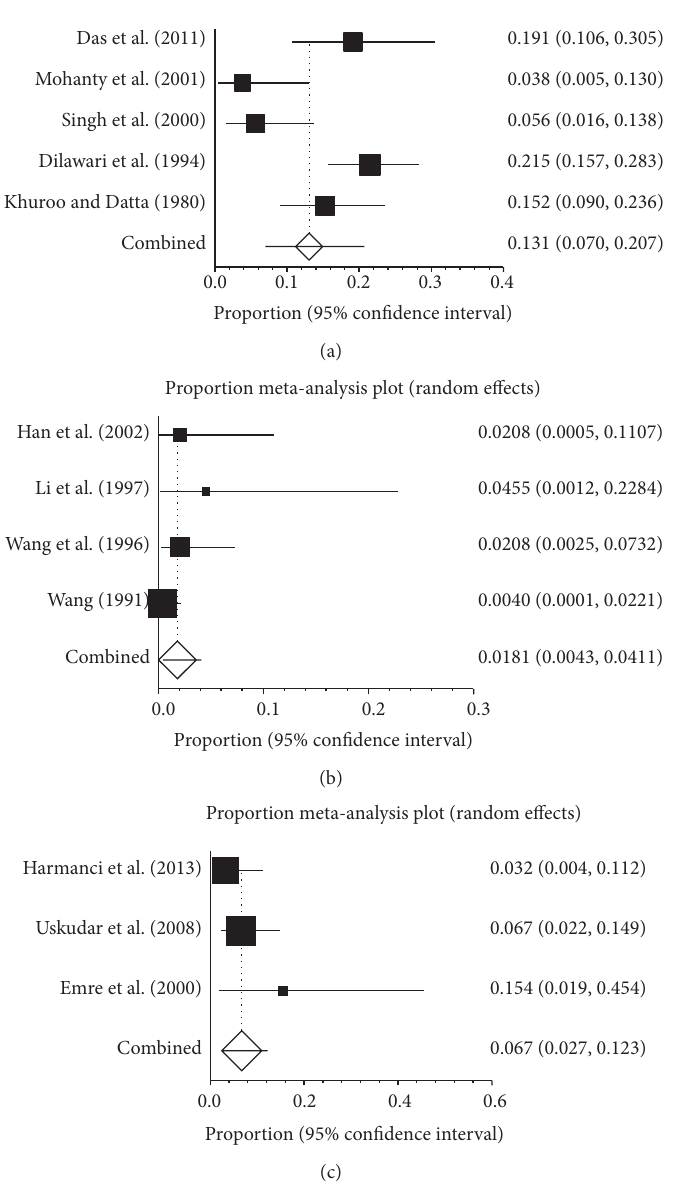
Figure 5: Forest plots of prevalence of pregnancy-related BCS in Indian (a), Chinese (b), and Turkish studies (c).